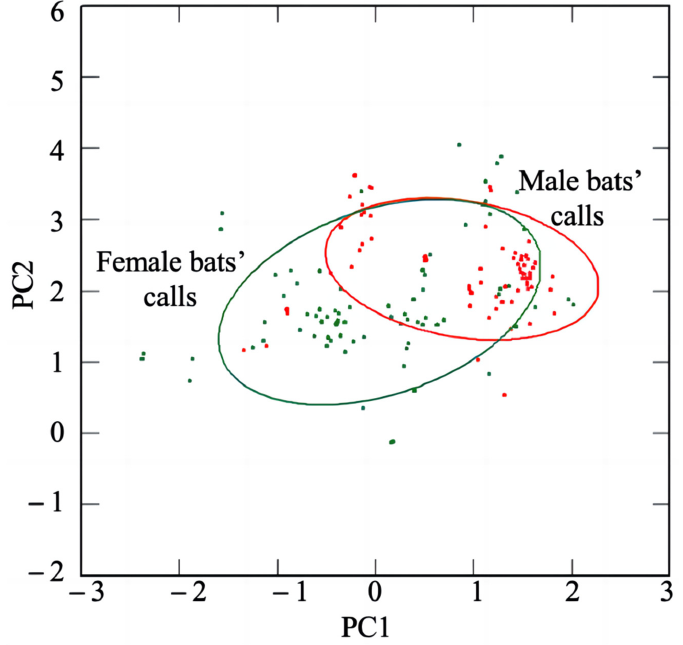
Figure 5. Confidence ellipse plot based on the first and second principal components. The confidence interval is 75%. The green circles denote the female calls, and the red circles denote the male calls. Table 1. Description of acoustic parameters of echolocation calls of different sexes for Rhinolophus ferrumequinum .